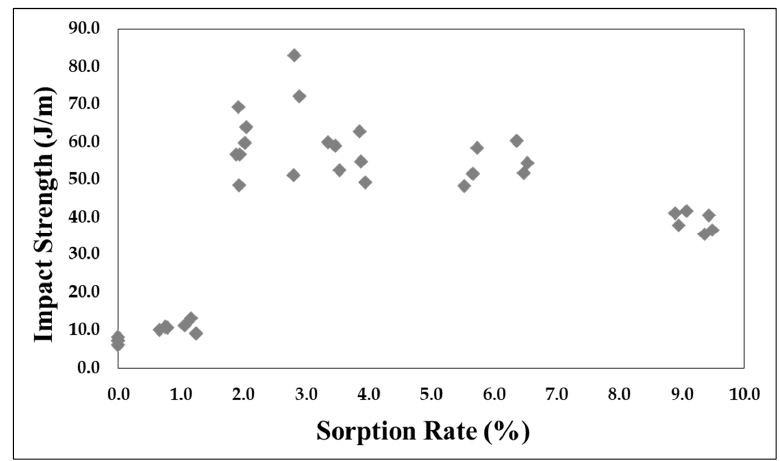
Figure 6. Impact strength of CO 2 dissolved APET.